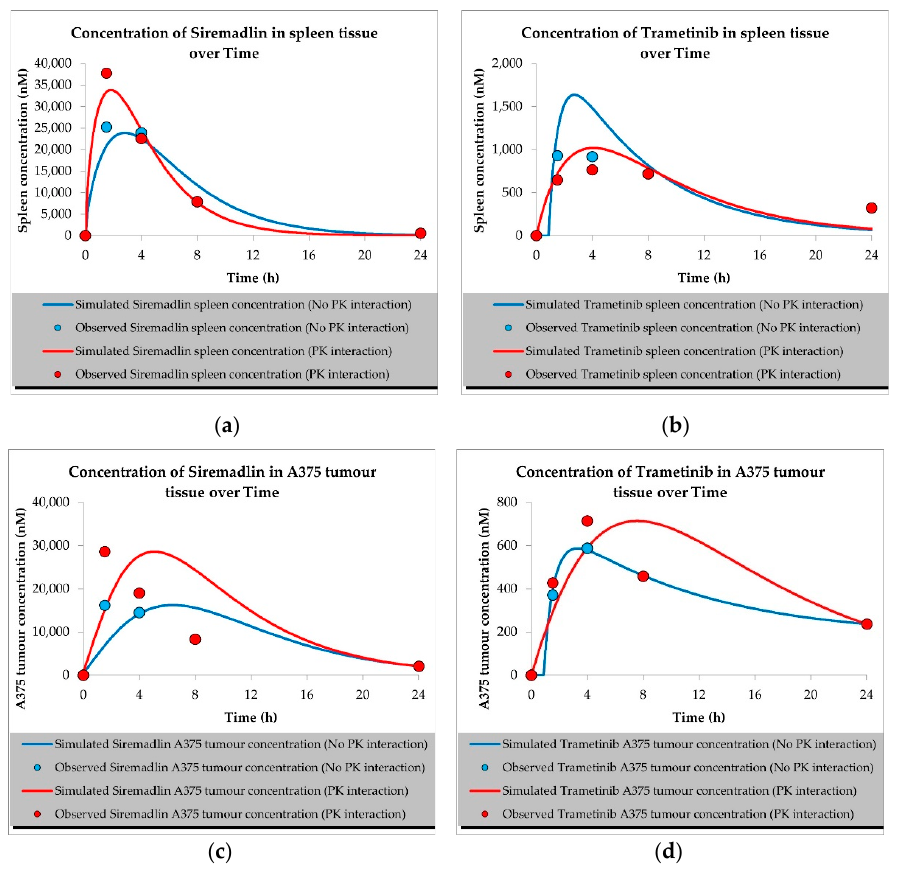
Figure 7. Values of predicted concentrations with and without PK interaction for ( a ) siremadlin and ( b ) trametinib in spleen tissue; ( c ) siremadlin and ( d ) trametinib in A375 tumour tissue; observed data are means from n = 3.